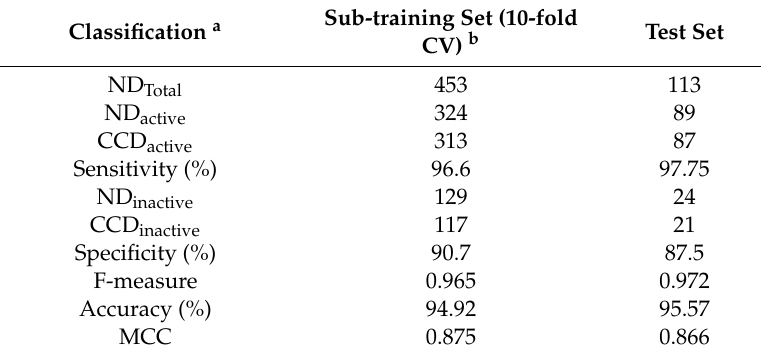
Table 4. Overall performance of the final mt-QSAR random forest (RF)